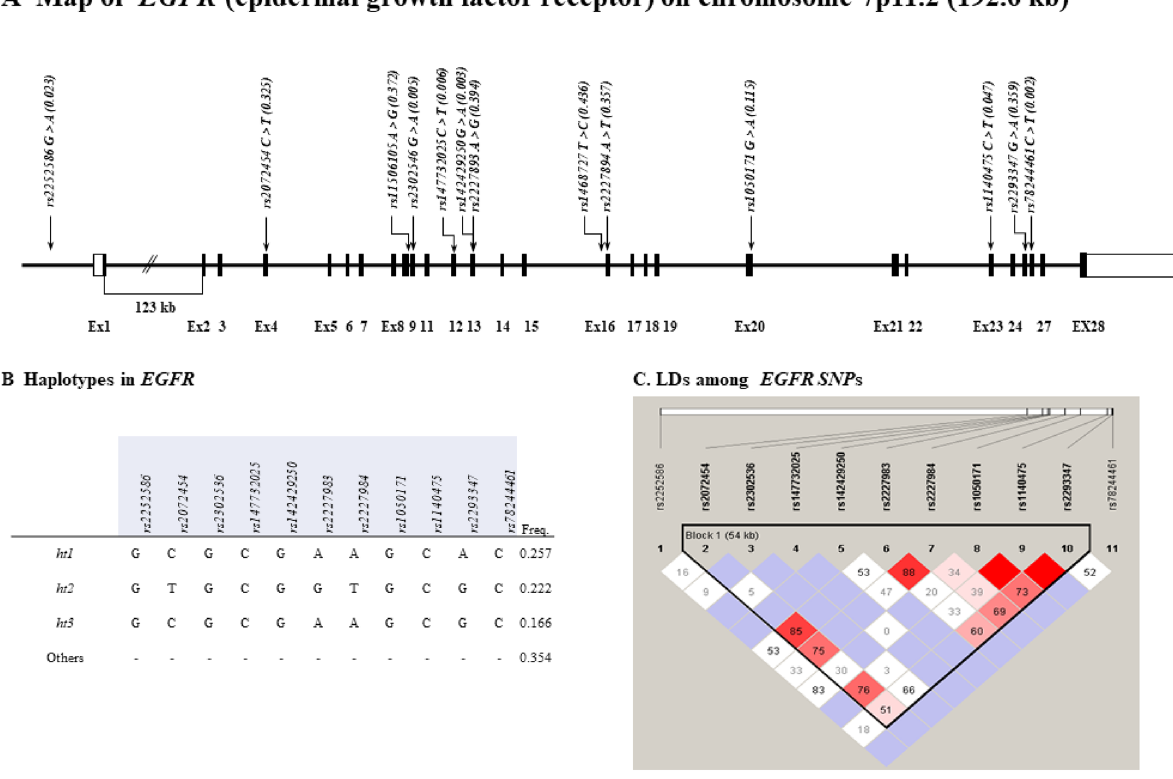
previous study on glioma. b In absolute LD with rs730437 (r 2 = 1 & D’ = 1) (SNiPA (https:// snipa. helmh oltz- muenc hen. de/ snipa3/)). c Bonferroni-adjusted P -values by 13 SNP